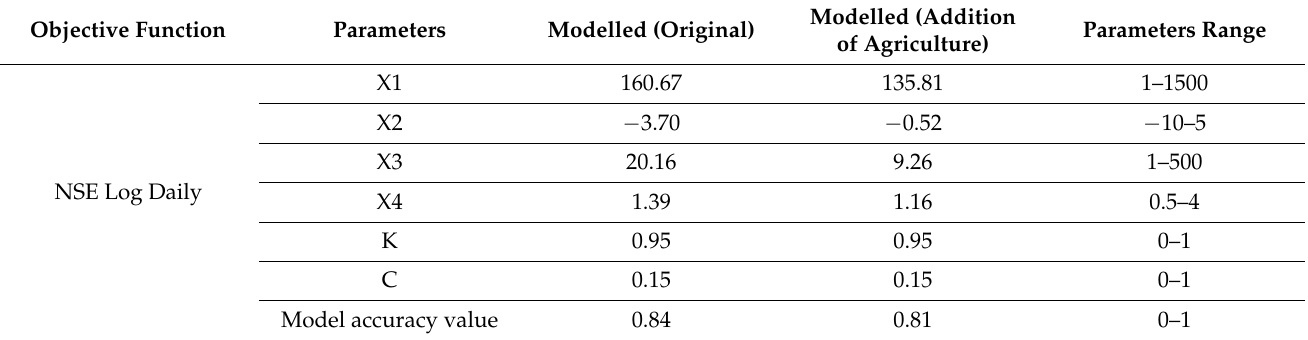
Table 10. The parameters of the rainfall–runoff models before and after climate change.